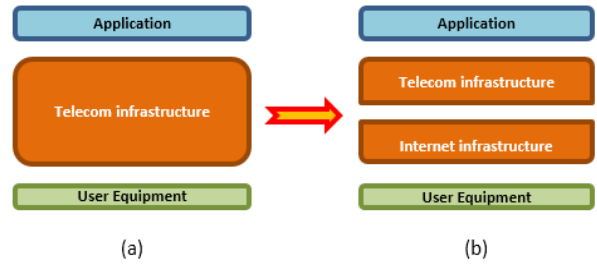
Figure 1: Telecom infrastructure used as a network layer, (a) used as a bearer network. (b) used as an